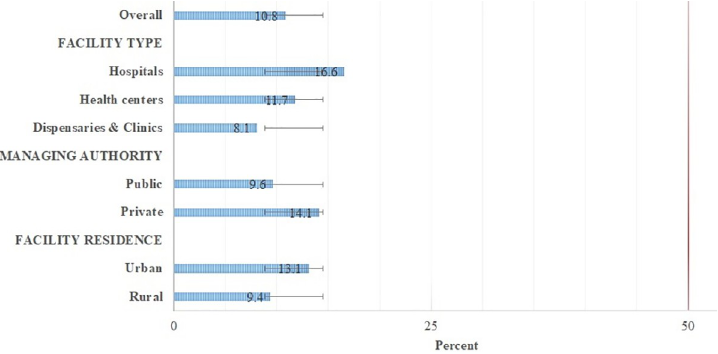
Fig 4. Overall readiness index by facility characteristics (N = 238). The red line depicts the cut off below which facility was regarded as having low readiness. Error bar represents the standard deviation from the mean readiness